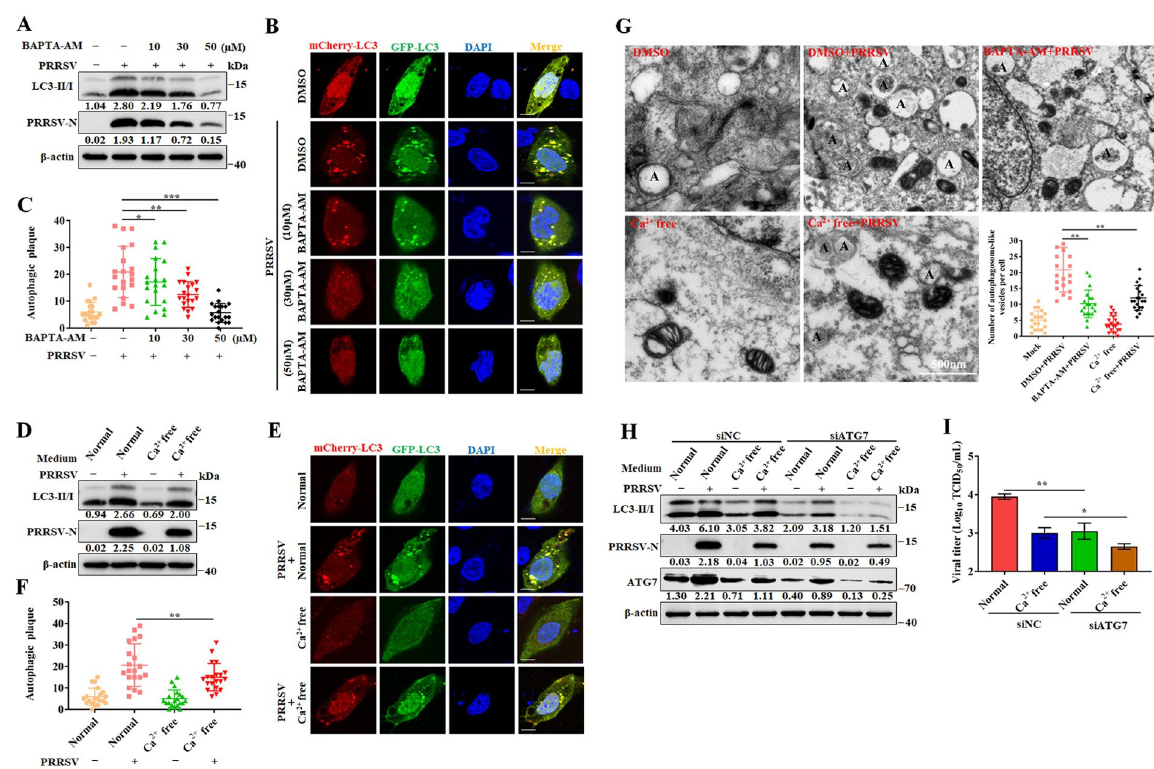
Fig 3. Cytosolic Ca 2+ promotes PRRSV replication through autophagy. (A-C) BAPTA-AM inhibits PRRSV induced autophagy. Marc-145 cells were infected with PRRSV (MOI = 0.1) and treated with BAPTA-AM for 24 h. ( A ) The ratio of endogenous LC3I to LC3II determined by western blotting. ( B ) Marc-145 cells were transfected with p-mCherry-GFP-LC3 for 24 h and then infected with PRRSV (MOI = 0.1) and treated with BAPTA-AM for another 24 h. LC3 puncta were visualized by confocal microscopy. Nuclei were stained with DAPI (blue). Scale bar = 5 μ m. ( C ) Quantitation of LC3 puncta formation. Results represent the number of LC3 puncta per cell in panel B (n = 20). (D-F) Extracellular Ca 2+ promotes PRRSV induced autophagy. ( D ) Marc-145 cells were infected with PRRSV (MOI = 0.1) and cultured in normal or Ca 2+ -free medium for 24 h. The ratio of endogenous LC3I to LC3II determined by western blotting. ( E ) LC3 puncta were visualized by confocal microscopy. Scale bar, 5 μ m. ( F ) Quantitation of LC3 puncta formation. Results represent the number of LC3 puncta per cell in panel E (n = 20). ( G ) The transmission electron microscopy analysis of virus-infected cells. Marc-145 cells were treated as shown in different groups (DMSO, DMSO + PRRSV, BAPTA-AM + PRRSV, Ca 2+ -free medium, Ca 2+ -free medium + PRRSV). 24 h later, cells were fixed and processed for electron microscopy analysis. A indicated the single- and double-membrane vesicles of autophagosome. The numbers of autophagosome were quantified from 20 different images in each group. (H-I) Marc-145 cells were transfected with control siRNA (siNC) or siRNA targeting ATG7 (siATG7) for 24 h, and then infected with PRRSV (MOI = 0.1) for another 24 h in normal or Ca 2+ -free medium. ( H ) PRRSV-N protein levels and the LC3-I/II ratio was determined by western blotting. ( I ) TCID 50 of PRRSV in cell supernatants. The protein levels were quantified by Image J and normalized to β -actin. Data are expressed as means ± SD, n = 3 in G or n = 20 in C, F and G. * p < 0.05; ** p < 0.01; *** p < 0.001. The data are representative of results from three independent